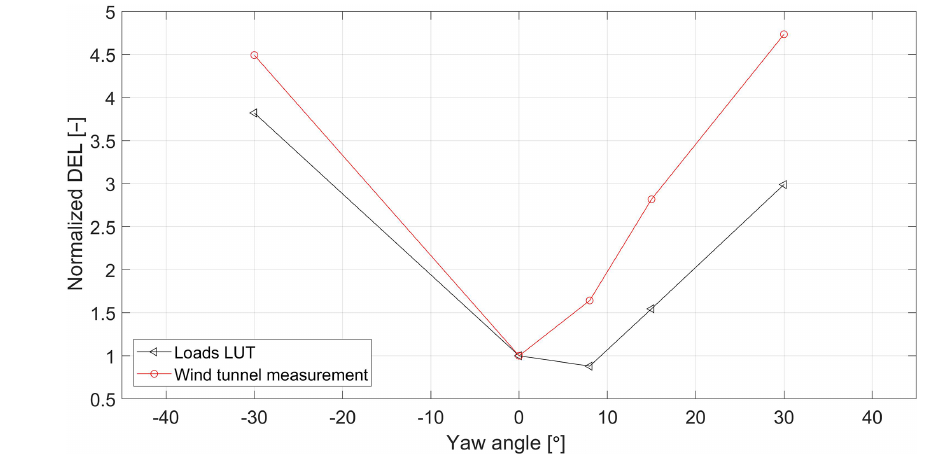
Figure 4. Normalized blade root out-of-plane loads: Mexico wind tunnel measurements vs. LUT database prediction